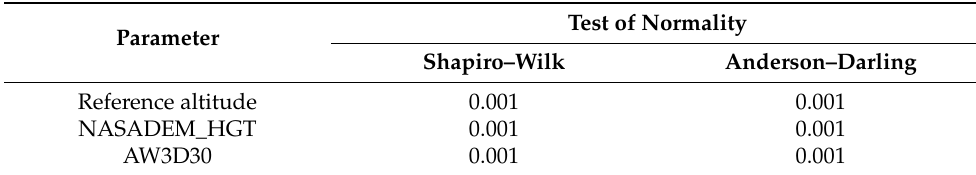
Table 4. Normality tests of reference altitudes and those obtained by the NASADEM_HGT and AW3D30